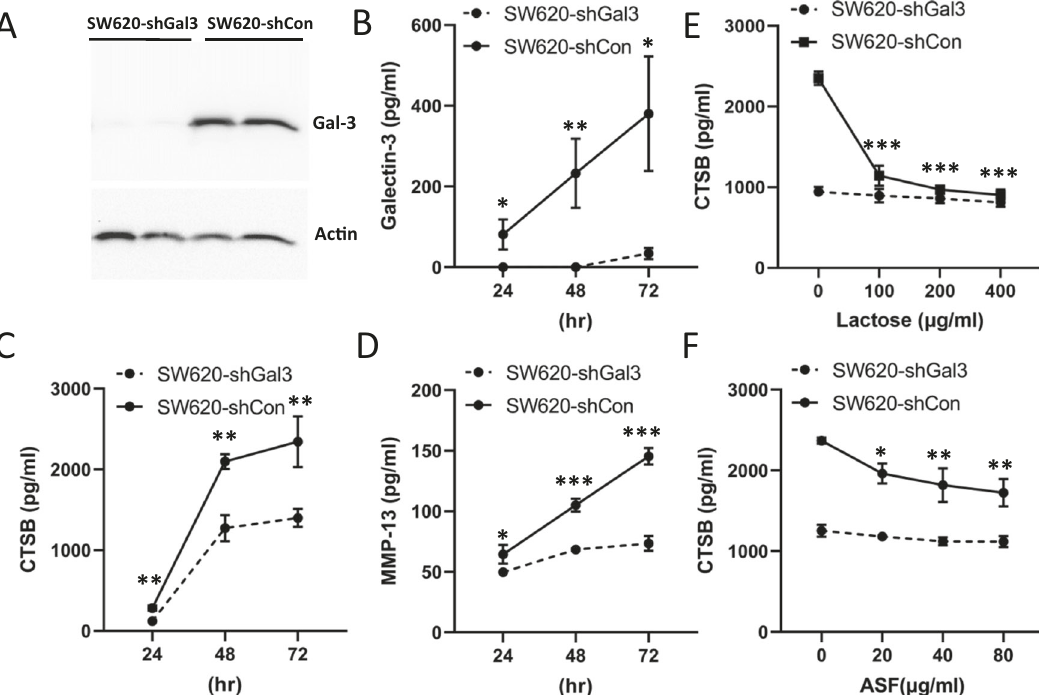
Fig. 3 Galectin-3 expression and secretion by cancer cells promotes protease secretion. Amounts of galectin-3 expression and secretion in galectin-3 knockdown SW620-shGal3 and control SW620-shCon cells were assessed by immunoblotting ( A ) and galectin-3 ELISA ( B ). SW620- shCon cells secreted higher concentrations of cathepsin-B ( C ) and MMP-13 ( D ) than SW620-shGal3 cells when assessed by ELISA. The galectin- 3-mediated cathepsin-B secretion was inhibited by the presence of galectin-3 inhibitors lactose ( E ) and ASF ( F ). Data are presented as mean ± SD from three independent experiments, each in triplicate. *** P < 0.001, ** P < 0.01, * P < 0.05 (ANOVA).